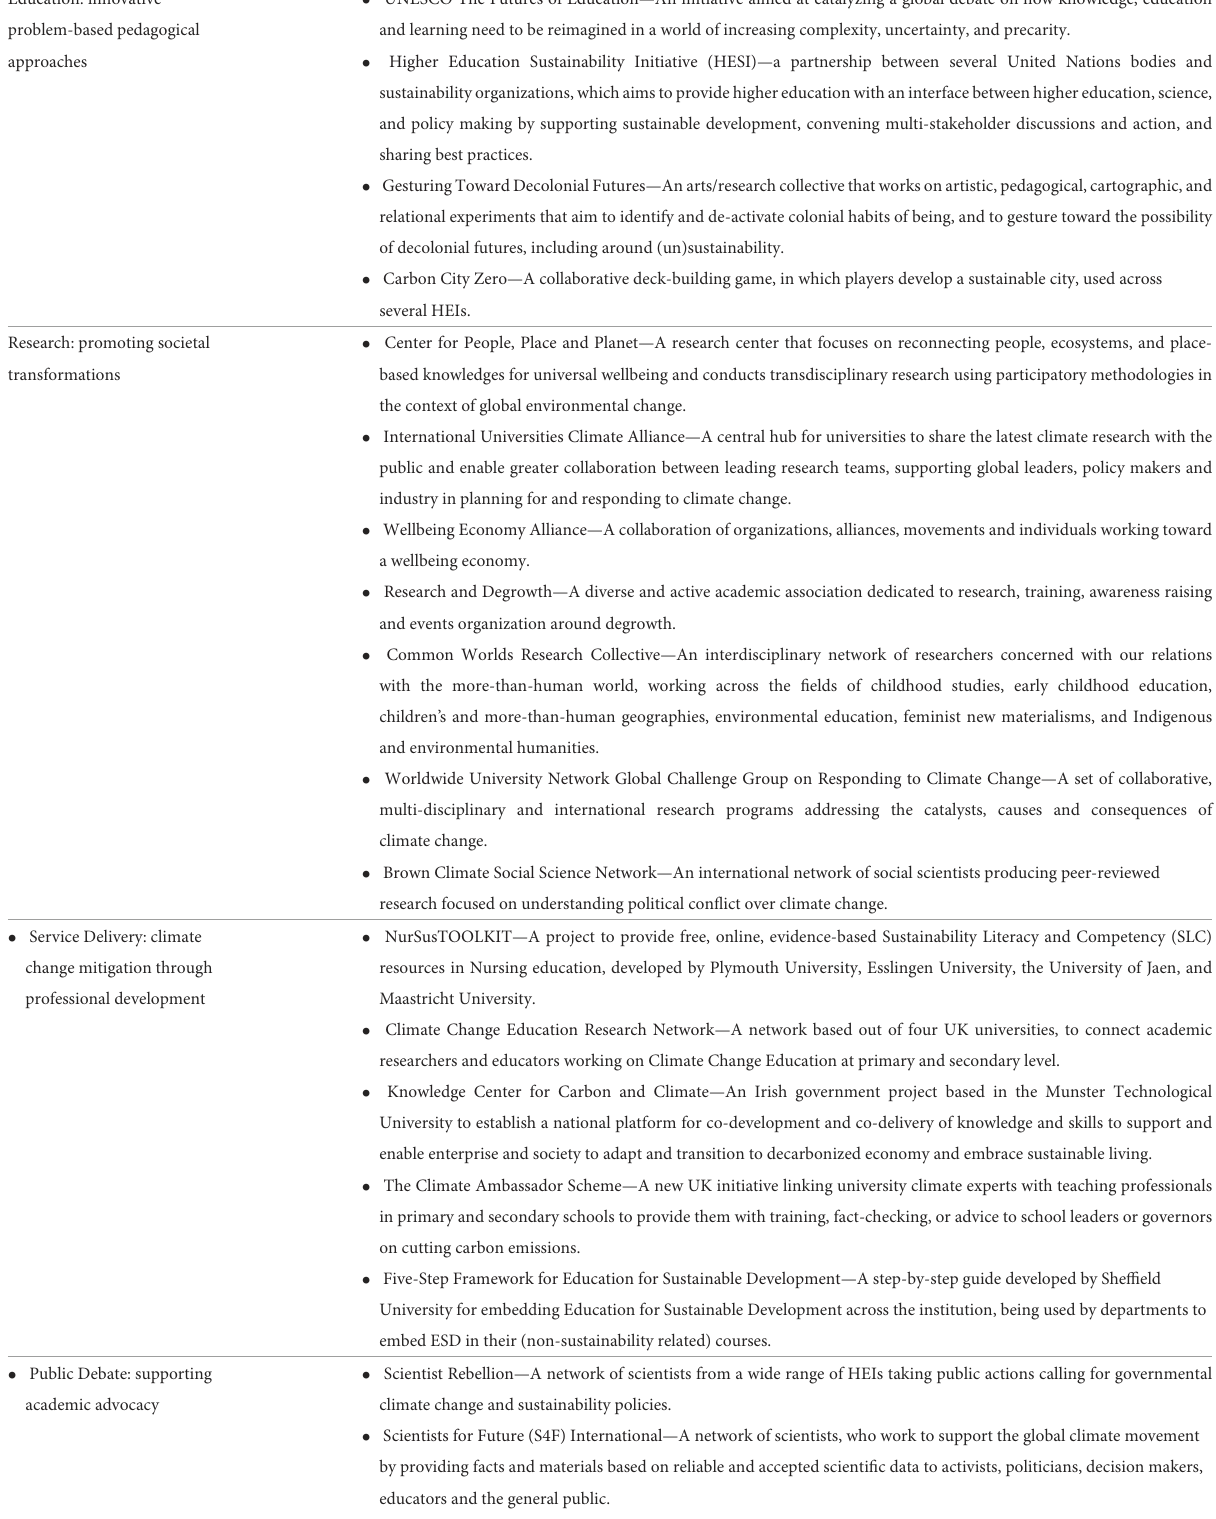
TABLE 1 Promising Trends in sustainability-related trends in higher education based on literature and case